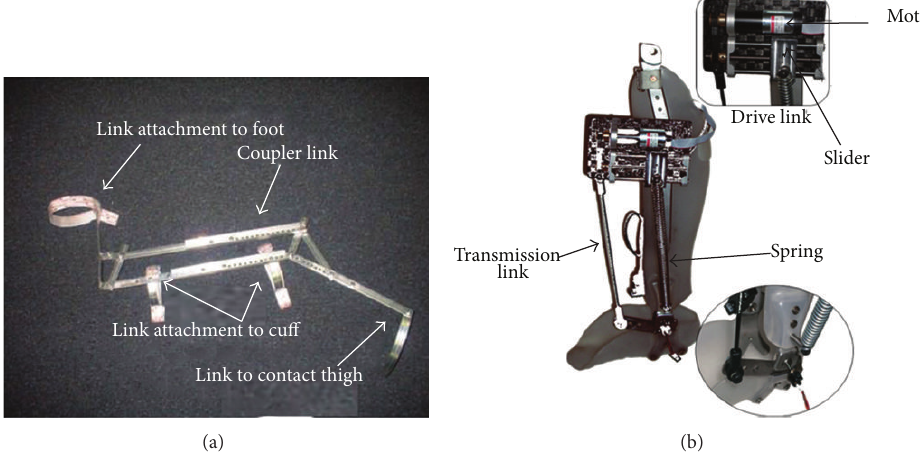
Figure 9: (a) Passive AFO with four-bar mechanism [43]. (b) An AFO with insertion point eccentricity control [9].